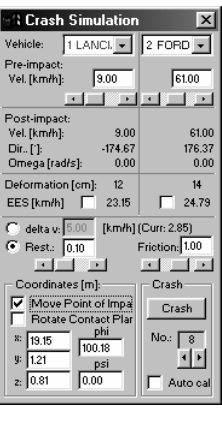
Fig 7. The parameters of collision of the